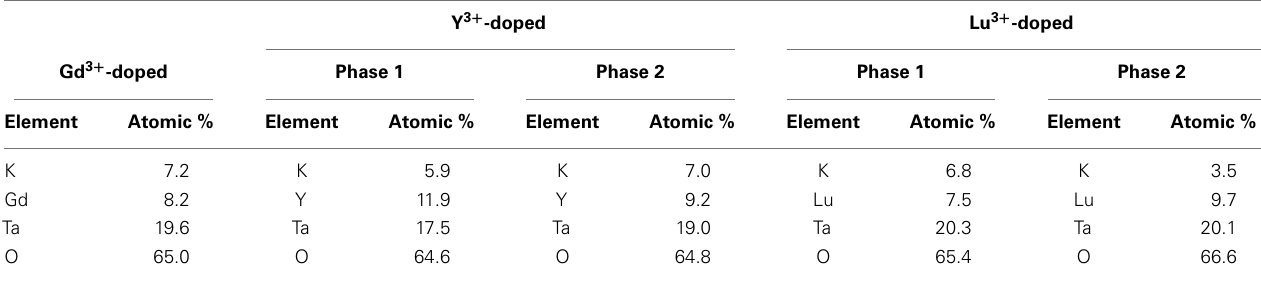
Table 1 | EDS analysis of the tantalate pyrochlores give five different groups of chemical compositions, each with a distinct atomic percentage of cation composition . Y 3 + -doped Lu 3 + -doped Gd 3 + -doped Phase 1 Phase